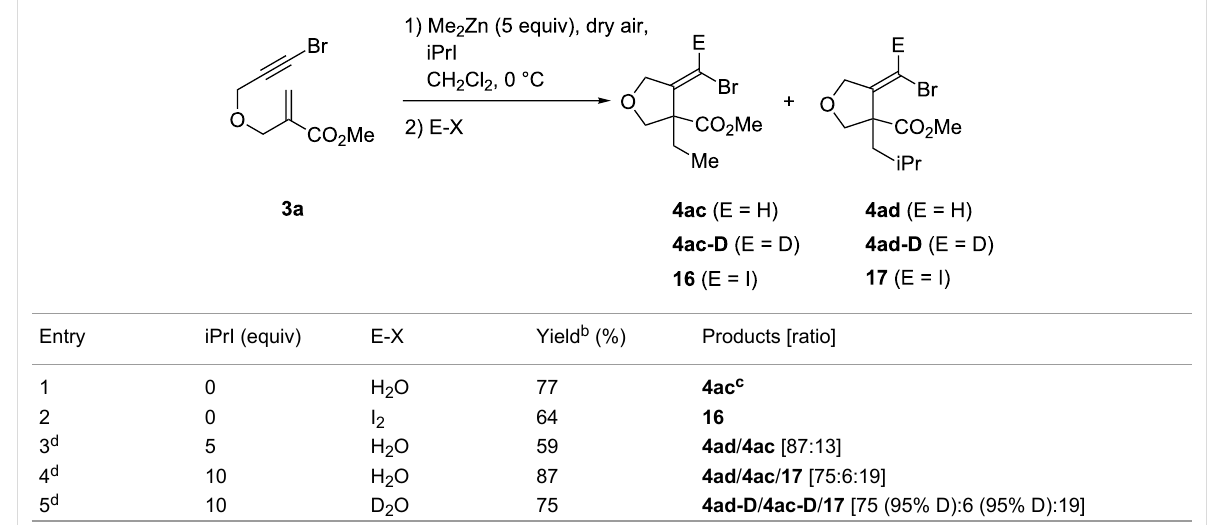
Table 3: Me 2 Zn-mediated 1,4-addition/carbozincation of alkyl iodides with 3a in the presence of added air. a